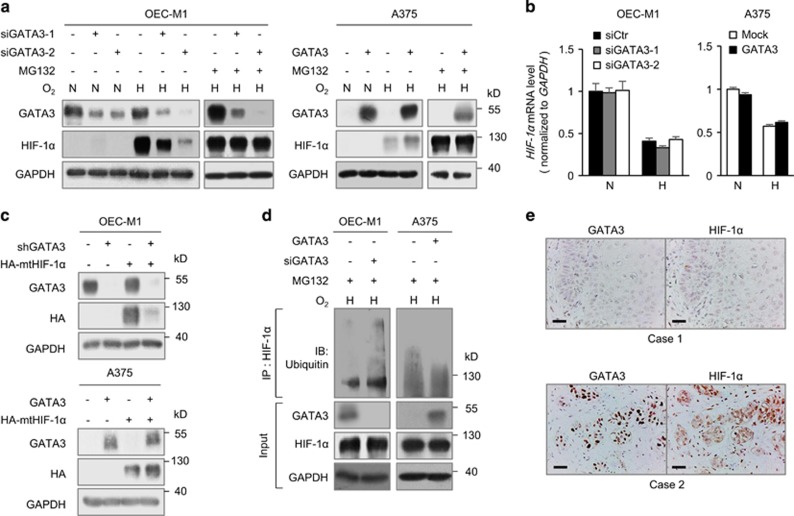
GATA3 expression increases HIF-1α protein levels. (a) Western blot analysis of GATA3 and HIF-1α under normoxia (N) or hypoxia (H) for overnight with or without a proteasome inhibitor, MG132 (20 μM), as indicated. GAPDH was an internal control. OEC-M1 cells were transfected with non-targeting siRNA or GATA3 siRNA (siGATA3-1 or siGATA3-2) and A375 cells were transfected with Mock or GATA3 plasmid. (b) Real-time RT-PCR analysis of HIF-1α mRNA expression. The total RNA was extracted from cells grown under normoxia or hypoxia for overnight. The results are represented as mean±s.d. from three independent experiments. (c) Western blot analysis of GATA3 and P402A/P564A HIF-1α mutant. GAPDH was an internal control. pLKO or shGATA3/pLKO (shGATA3) expressing OEC-M1 stable transfectants as well as Mock or GATA3 overexpressing A375 stable transfectants were transfected with empty vector or HA-P402A/P564A HIF-1α/pcDNA3.1 (HA-mtHIF-1α). (d) Effects of GATA3 on HIF-1α ubiquitination. OEC-M1 cells transfected with non-targeting siRNA or GATA3 siRNA (siGATA3-2) and A375 cells transfected with Mock or GATA3 plasmid were incubated with MG132 (20 μM) under hypoxia for 6 h. Cell lysates were immunoprecipitated with anti-HIF-1α antibody and then immunoblotted with anti-ubiquitin antibody. GATA3, HIF-1α and GAPDH in whole cell lysates (input) were shown. (e) Representative images of immunohistochemical staining of GATA3 and HIF-1α in serial sections of HNSCC tissues. Scale bars, 50 μm.